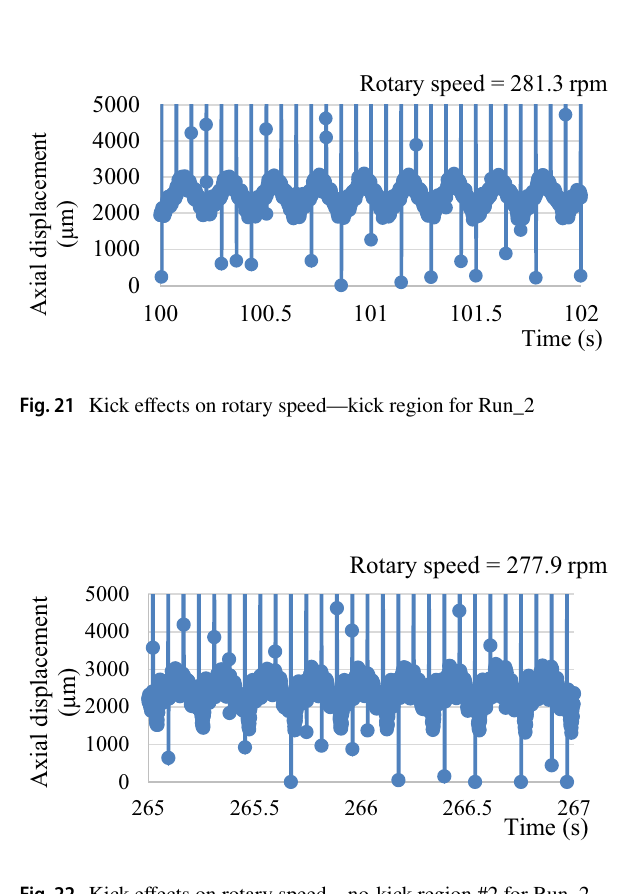
Fig. 20 Kick effects on rotary speed—no-kick region #1 for Run_2